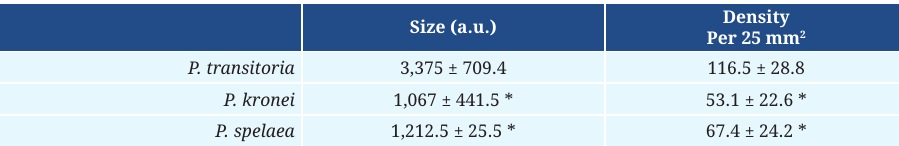
TABLE 1 | Density and relative size of the studied species (* p ≤ 0.05 in comparisons with P. transitoria ). (a.u. arbitrary unit of Image J